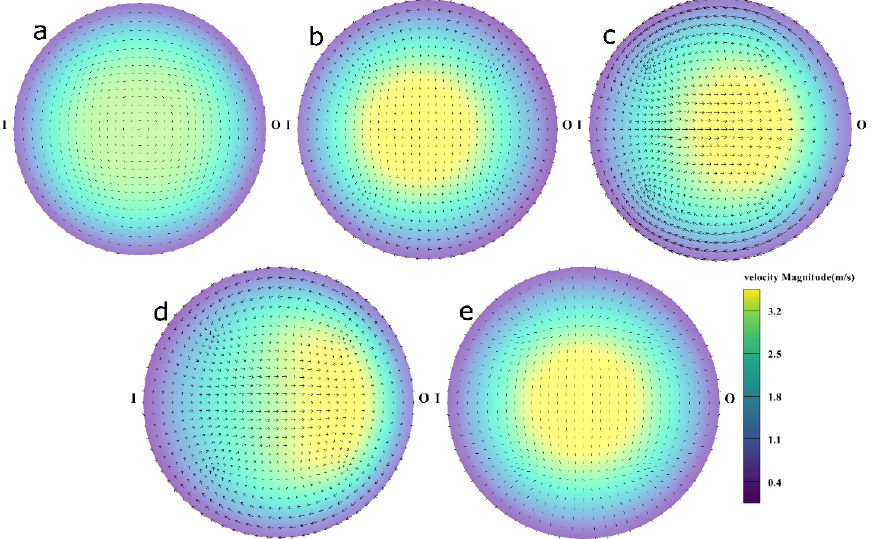
Figure 6. In the 90° channel at the conveying rate of 4.75 cm 3 /s, the profiles of the velocity magnitude and the velocity vectors on the five slices as indicated in Figure 2a. The slices ( a – e ) are from the inlet to the outlet.